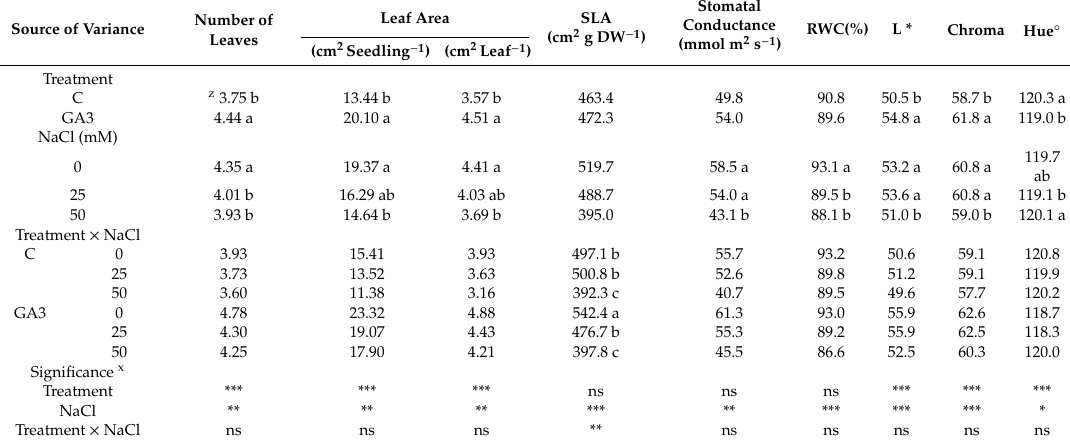
Table 4. E ff ects of the gibberellic acid treatment (C, not treated; GA3, GA 3 -treated seedlings) and salt stress (0, 25, and 50 mM NaCl in the irrigation water) on leaf characteristics of sweet pepper seedlings. Source of Variance